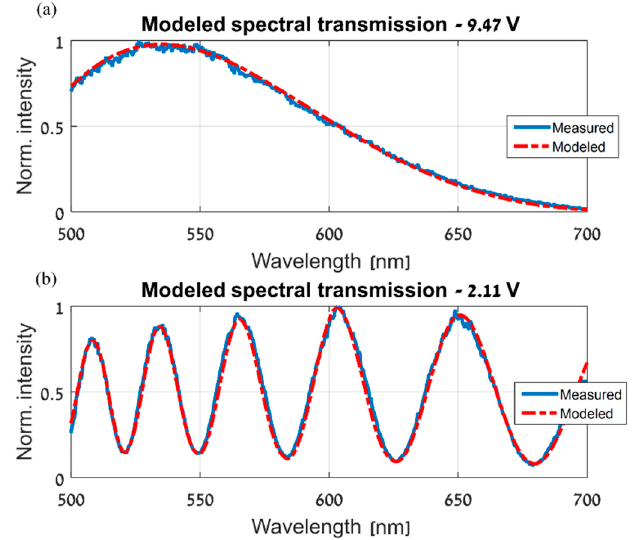
Figure 10. The parametric model as estimated at the chosen base location, ( x 0 , y 0 ) , at two di ff erent voltages applied to the CS-MUSI's LCC: ( a ) 9.47V and ( b ) 2.11V.